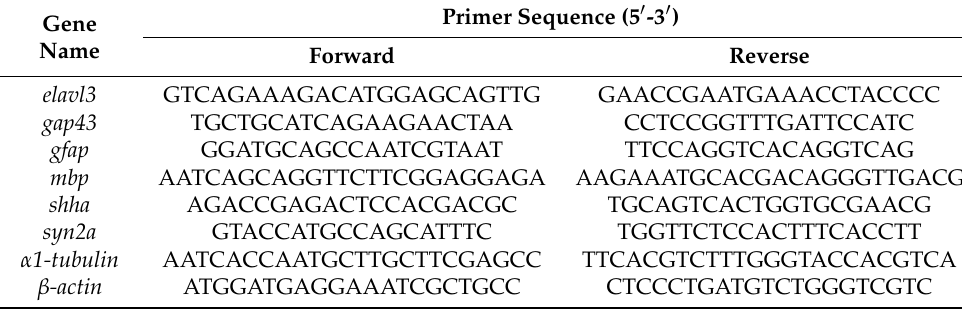
Table 3. Primer sequences of genes for quantitative real-time PCR